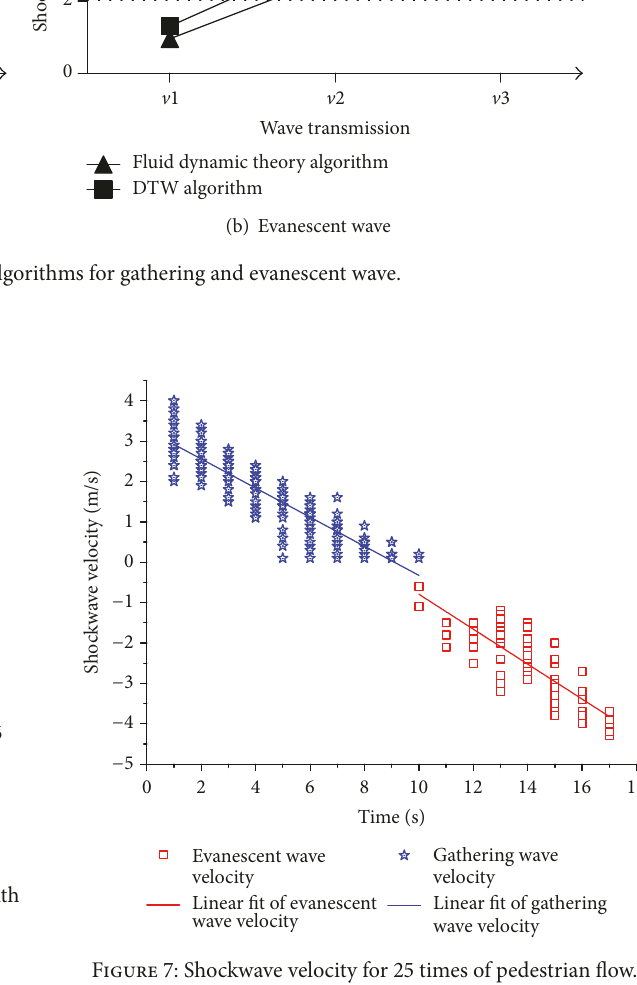
Figure 7: Shockwave velocity for 25 times of pedestrian